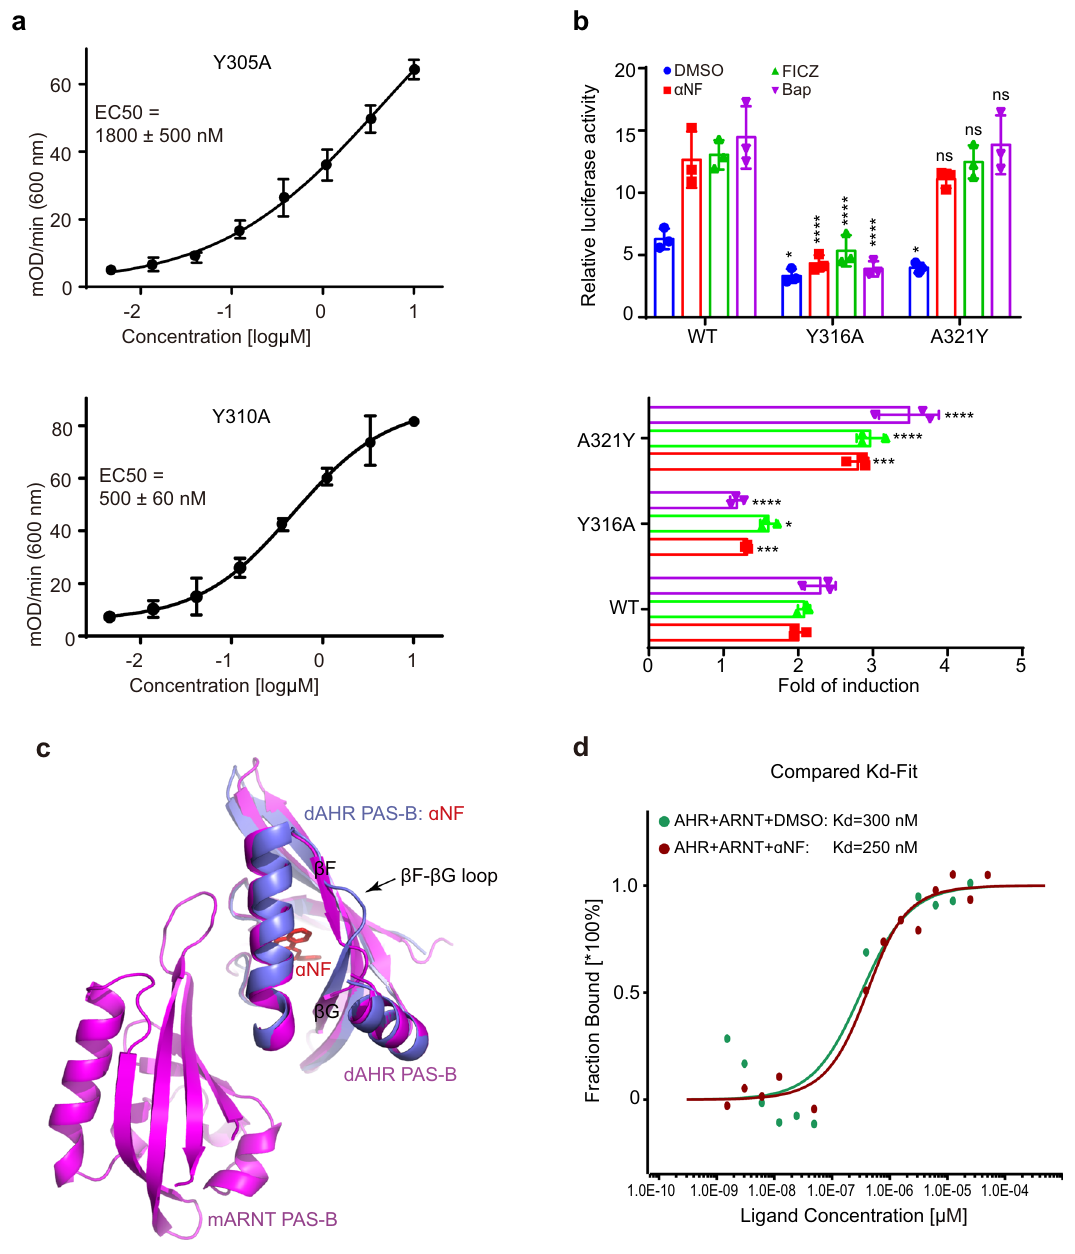
Fig. 5 | Analysis of the dAHR:mARNT PAS-B heterodimer interface. a The binding af fi nities of dAHR PAS-B mutants to mARNT PAS-B measured by ELISA. b DRE luciferase reporter assay examining the effect of AHR mutation on the transactivation of mAHR in HEK293T cells in the presence or absence of agonists. FICZ, β NFandBaPweresuppliedat200nM,500nMand200nM,respectively.The lower panel shows the fold of induction in luciferase activity due to ligand treat- ment(luciferaseactivityinthepresenceofliganddividedbythatinthepresenceof DMSO). c Superimposition of the dAHR PAS-B: α NF and dAHR